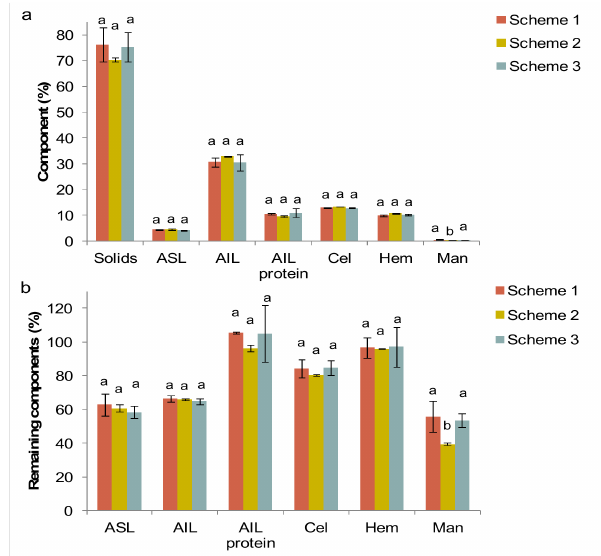
Figure 2. ( a ) Yield of solids (%) and content (%) of acid-soluble lignin (ASL), acid-insoluble lignin (AIL), protein in AIL, cellulose (Cel), hemicellulose (Hem), and mannitol (Man) in the remaining fraction from olive mill leaves (OML) after extraction using Schemes 1–3. ( b ) Corresponding recovery values (%) with respect to the initial amounts in